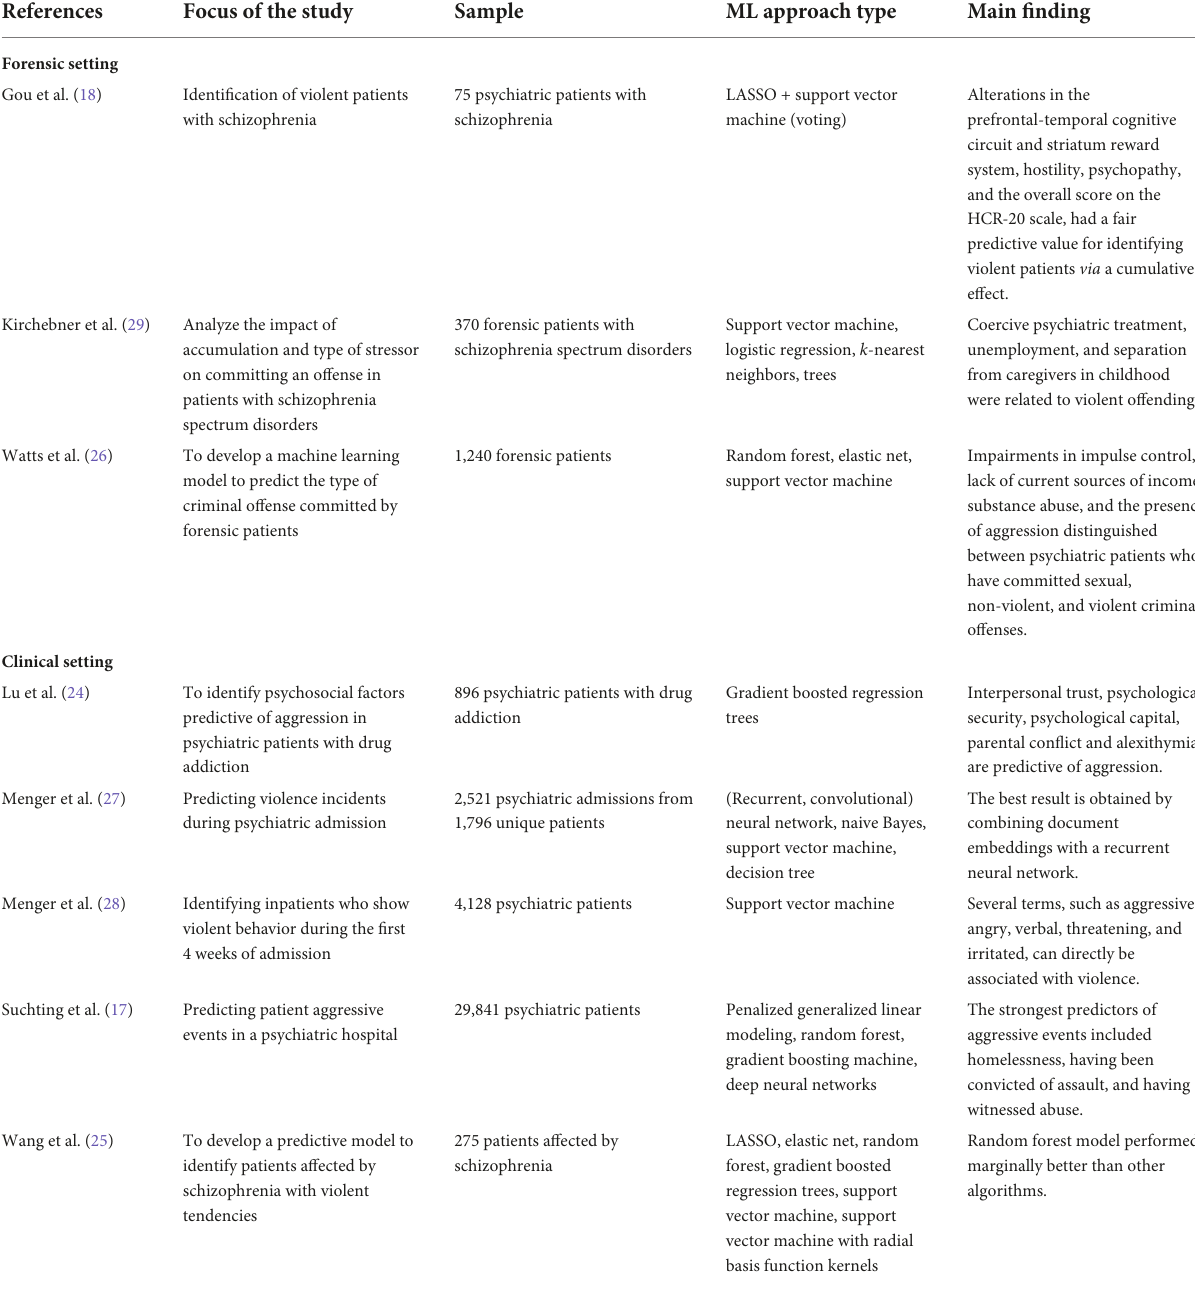
TABLE 1 Studies using ML models for predicting risk of aggression and/or